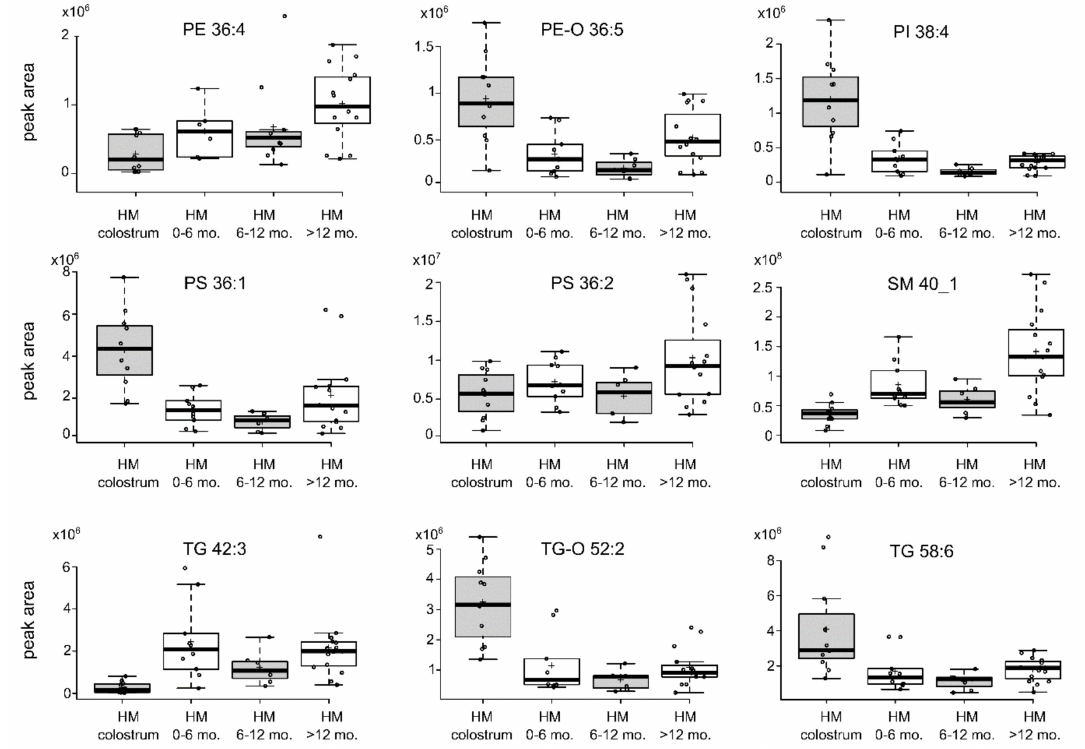
Figure 2. Comparison of the lipid peak area of samples collected in four lactation stages. The centre lines show the medians. The box limits indicate the 25th and 75th percentiles, as determined by R software. The whiskers extend 1.5-times the interquartile range from the 25th and 75th percentiles. The outliers are represented by dots; crosses represent sample means; data points are plotted as open circles. PE, glycerophosphoethanoloamine; PE-O, ether analogue of glycerophoshoethanoloamine; PS, glycerophosphoserine, PI, glycerophosphoinositol; SM, sphingomyelin; TG, triacylglycerol; TG-O, ether analogue of